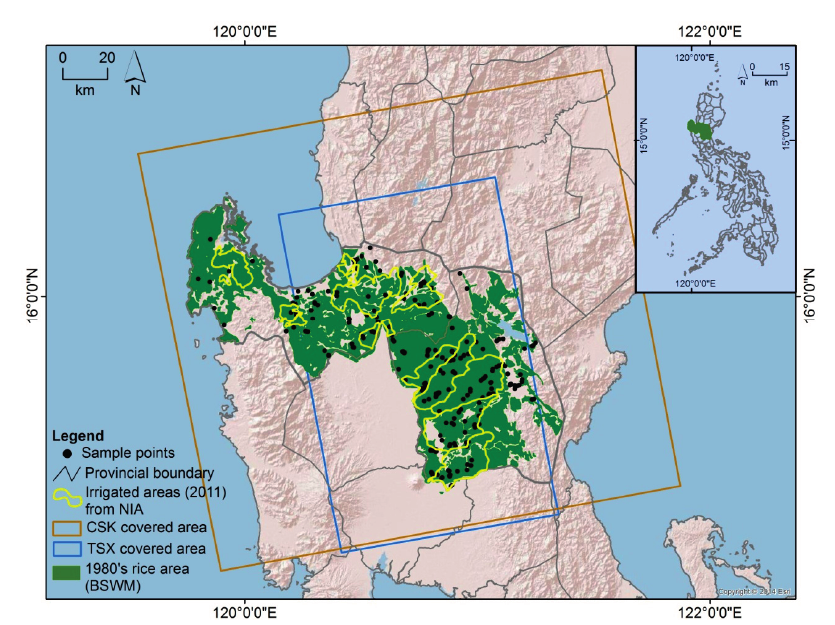
Figure 1. Pangasinan and Nueva Ecija showing rice area in the 1980s (green). The brown and blue boxes delineate coverage of CSK and TSX SAR products, respectively. MODIS tile h29v07 completely covers the area. The yellow line shows the boundary of irrigated areas as reported by NIA (2011) and the sites for ground data collection are in black